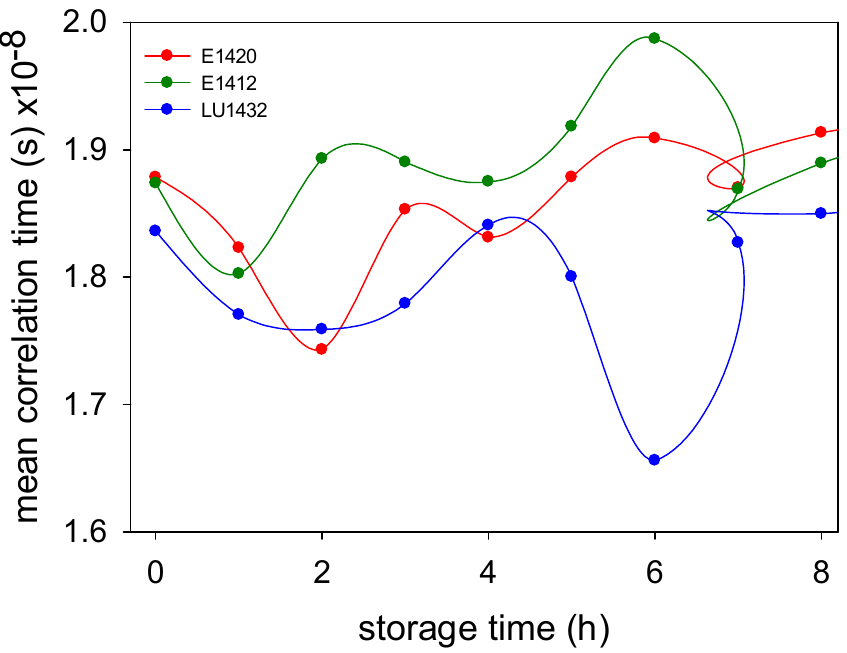
Figure 1. Time-related changes in values of correlation times in potato starch gels.